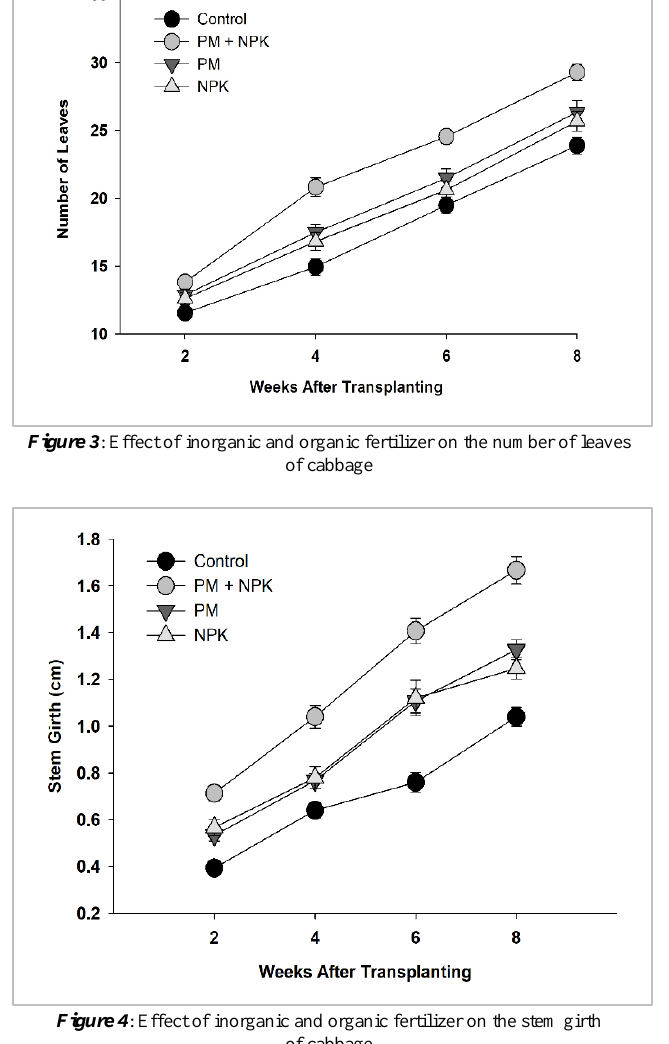
Figure 4 : Effect of inorganic and organic fertilizer on the stem girth of cabbage Effect of inorganic and organic fertilizer on the yield of cabbage Head diameter (cm)